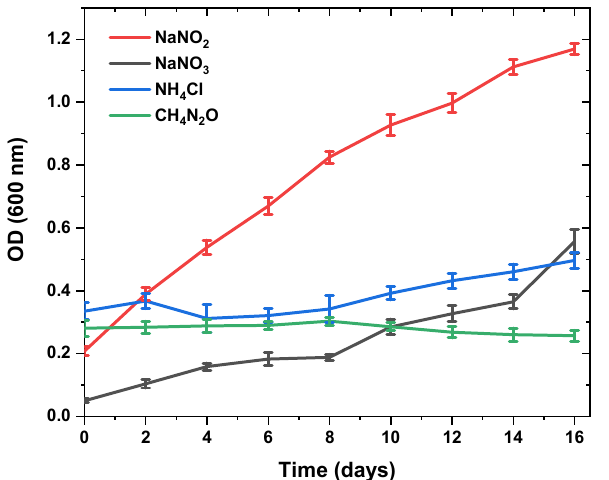
Figure 2. Plot showing the effect of different nitrogen sources on the optical density of N. shiloi . Reported results are the average of three replicates (i.e., n = 3), with error bars denoting one standard deviation about the